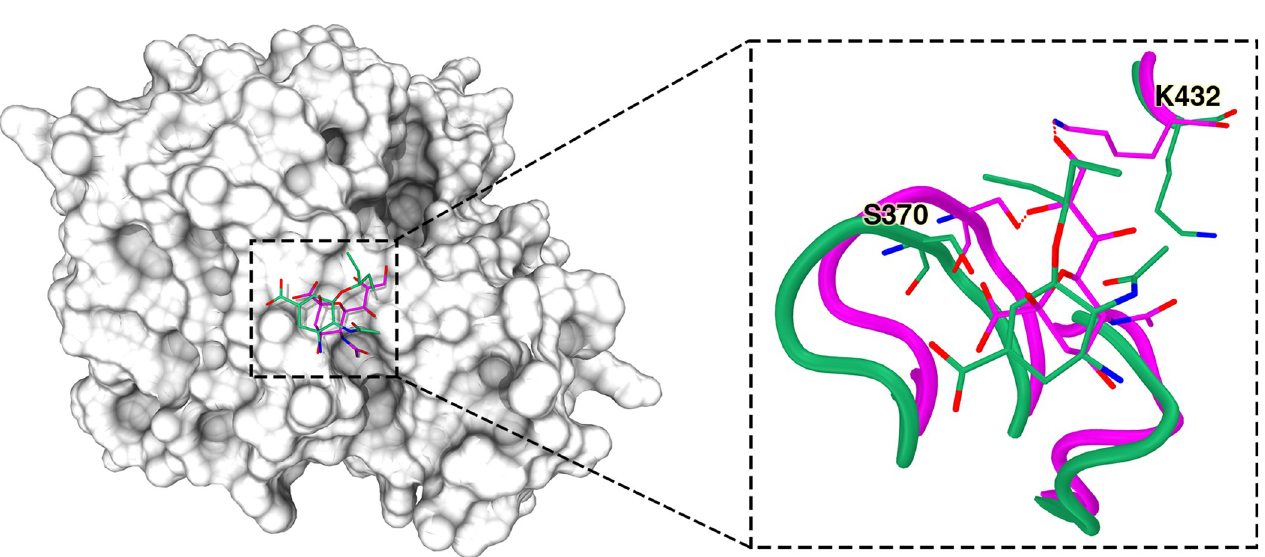
Fig 4. Comparison of the conformations of sialic acid and oseltamivir at the secondary binding site. The position outlined by the black dotted square in the left panel is the secondary binding site of NA. Emerald green in the right panel represents oseltamivir and NA in the simulation, and magenta represents sialic acid and NA in the crystal structure (PDB ID: 1MWE). Hydrogen bonds between sialic acid and partial residues in the secondary binding site are shown as dashed red lines.